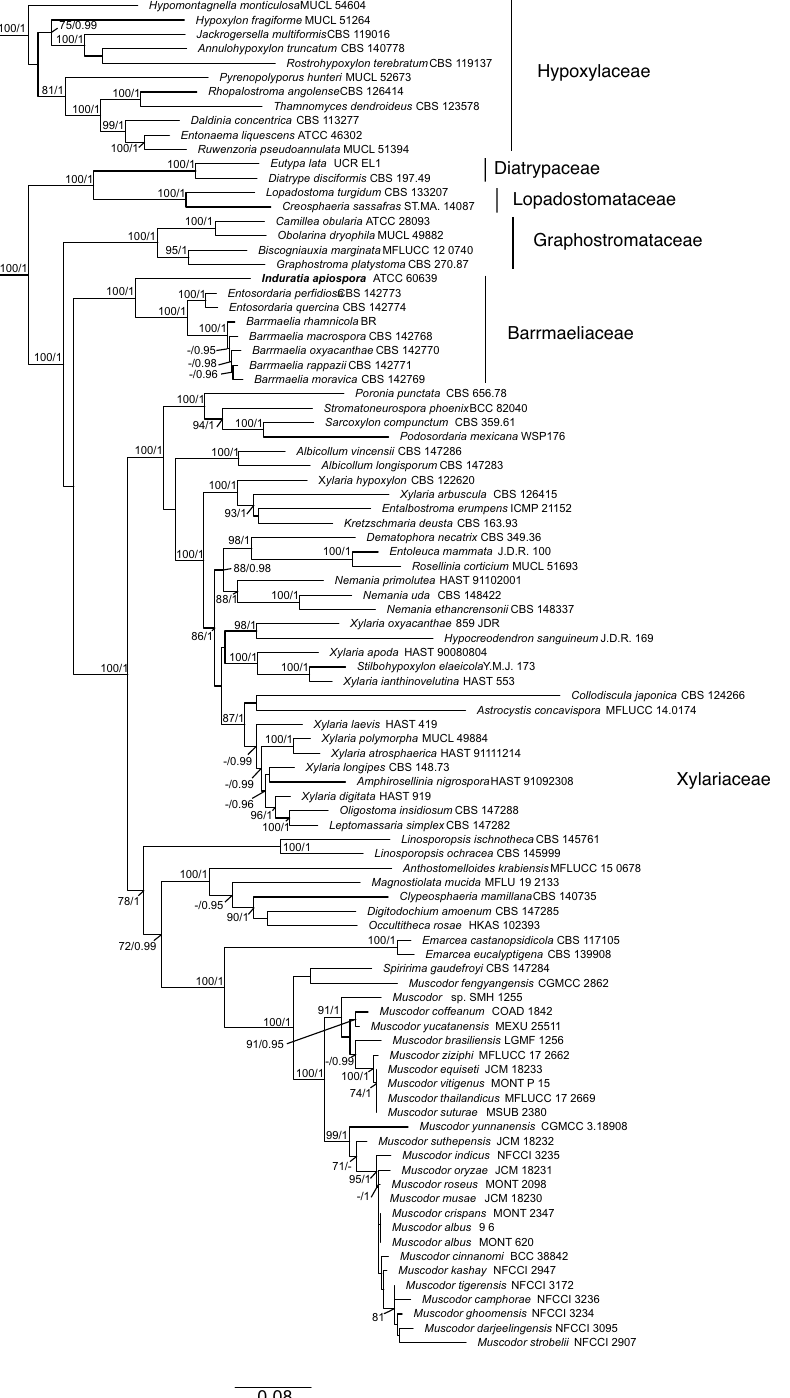
Fig. 3 Maximum Likelihood Tree (lLn 89939.9947) inferred from a manually edited alignment of ITS, LSU, rpb2 and tub2 sequences featuring = − sequences derived from Hypoxylaceae, Diatrypaceae, Lopadostomataceae, Graphostromataceae, Barrmaeliaceae and Xylariaceae. The position of the newly generated and concatenated sequences of Induratia apiospora are marked in bold. Bootstrap and Bayesian posterior probabilities and 0.95, respectively, are given at ≥